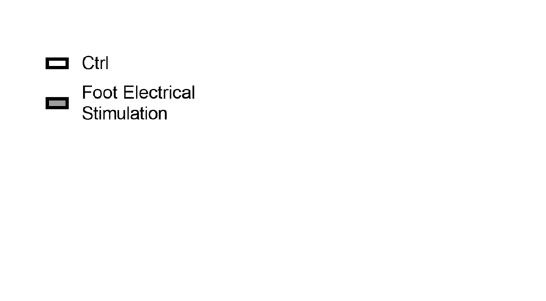
Figure 4. ( A ) The effects of FES on CRH in serum and the Hypothalamus. ( B ) The effects of FES on ACTH in serum and the pituitary. All data are presented as mean ± SD (n = 12). * P < 0.05 versus control group, ** P < 0.01 versus control group, *** P < 0.005 versus control group, **** P < 0.001 versus control group.